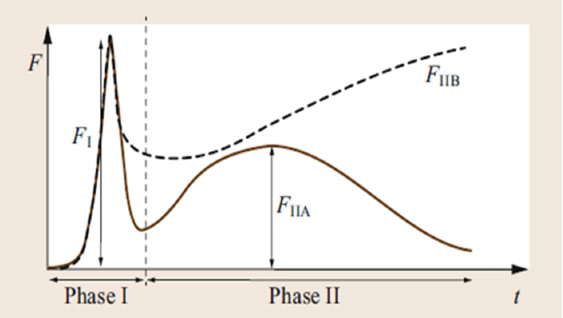
Figure 5. Force profiles of collision